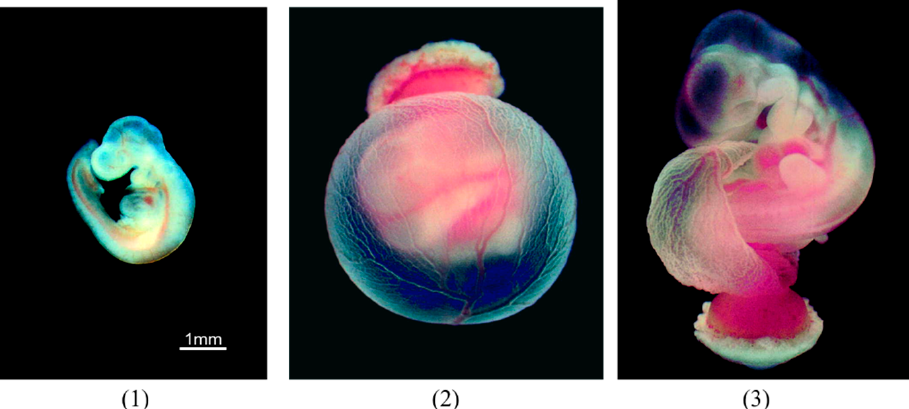
Figure 2. Morphological changes of rat embryos cultured in the control medium. ( 1 ) Whole rat embryo without the placenta and yolk sac isolated from the uterus (incubation time = 0). ( 2 ) Whole rat embryo with the placenta and yolk sac cultured for 24 h. ( 3 ) Whole rat embryo with the placenta and yolk sac cultured for 48 h. Scale bar = 1 mm.